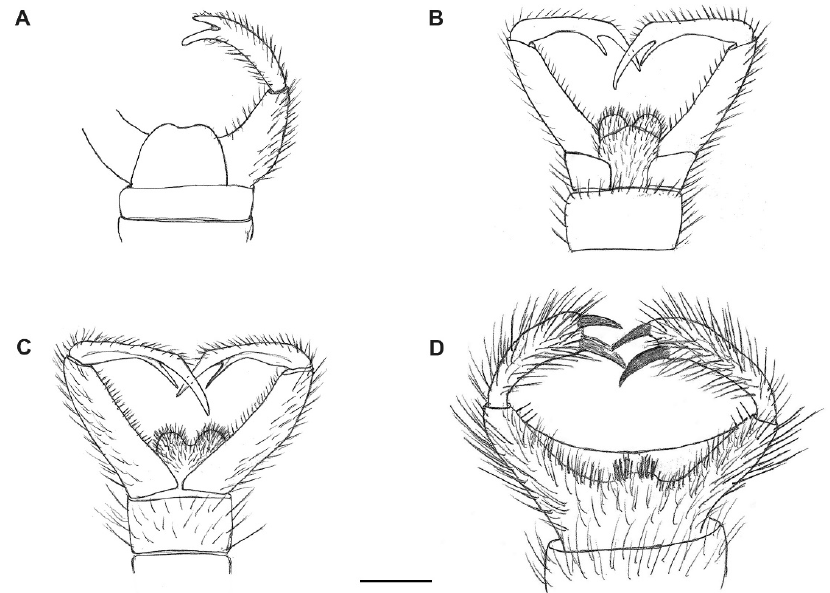
Figure 5. Male terminalia of Paleoplatyura agnieszkae sp. nov. ( A ), P. miae sp. nov. (( B ) dorsal, ( C ) ventral), and P. magnifica sp. nov. ( D ). Scale bar = 0.1 mm. Paleoplatyura miae sp. nov.